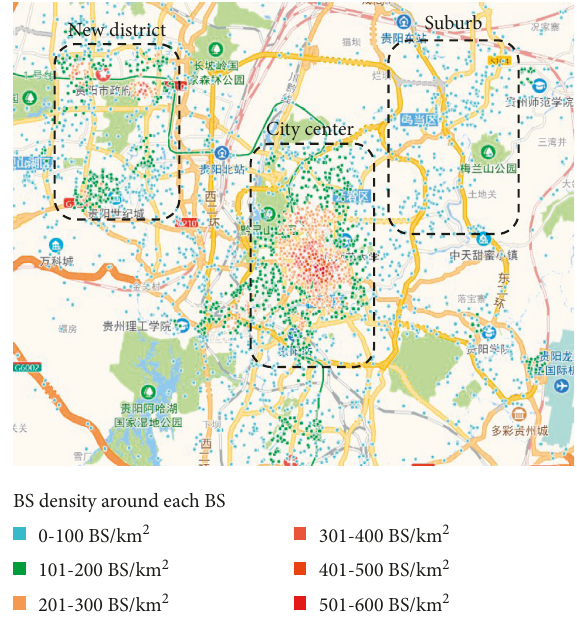
Figure 8: BS densities in different areas of Guiyang